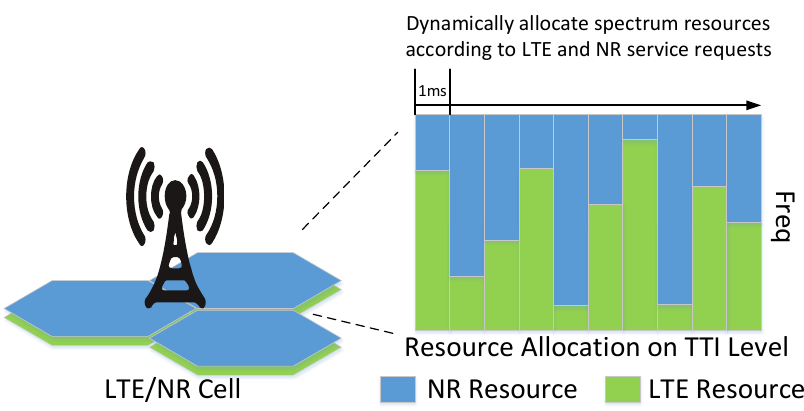
Figure 2. DSS dynamically adjusts spectrum